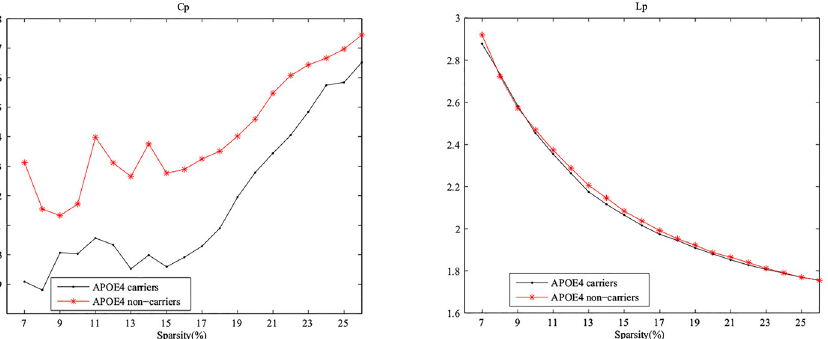
Fig 5. Mean clustering coefficients (Cp) and mean absolute path lengths (Lp) in APOE ε 4 carriers and APOE ε 4 noncarriers.